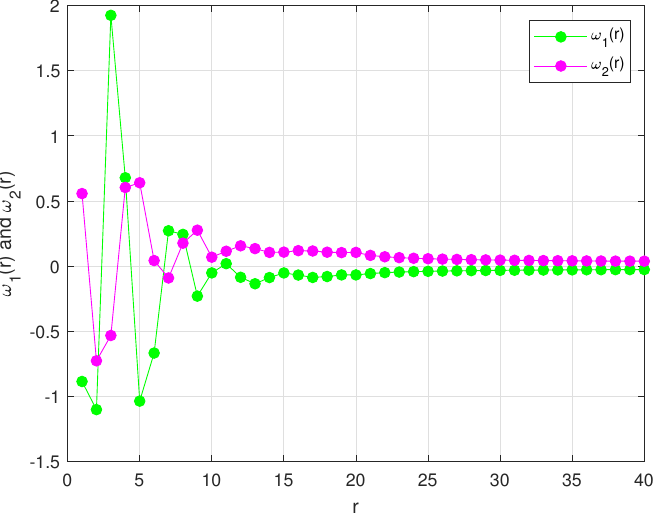
Figure 1. State responses of the system in